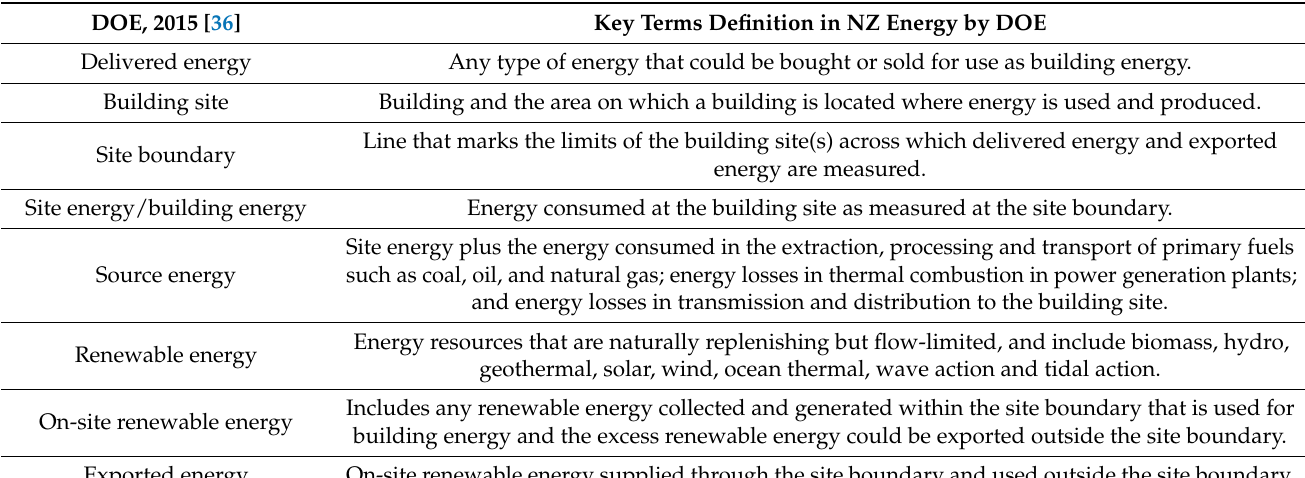
Table 2. DOE’s key terms definition in NZ standard release